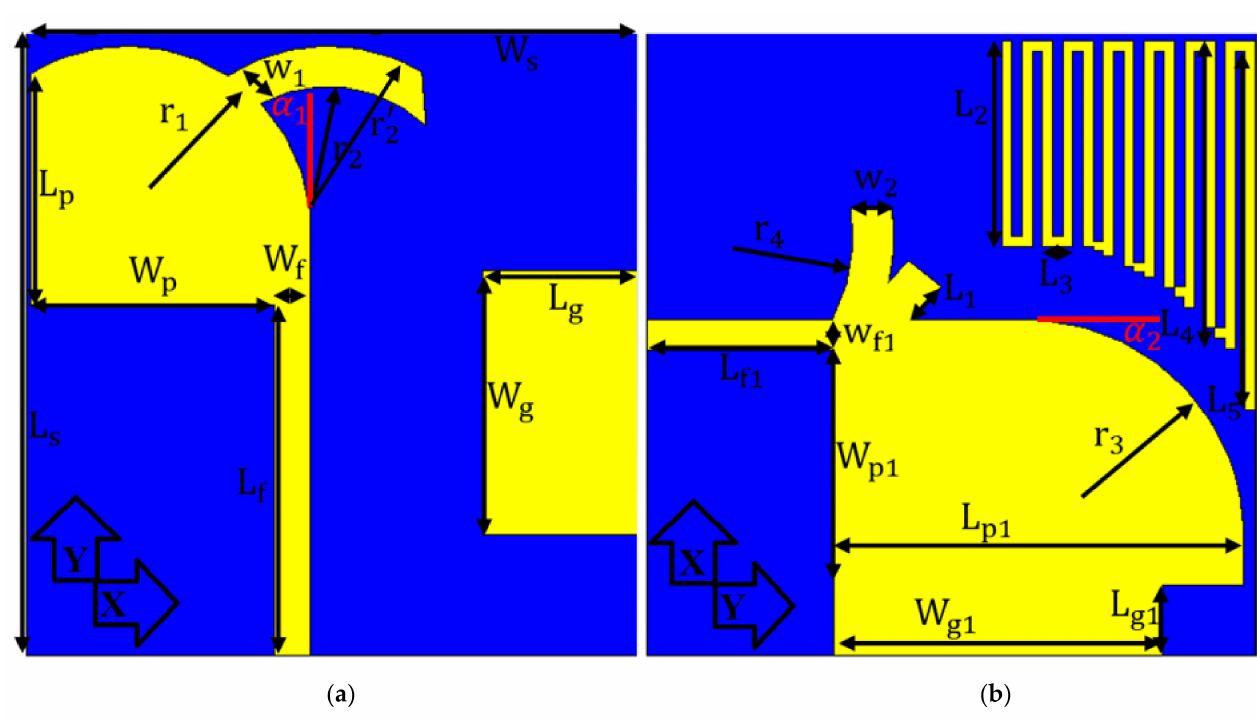
Figure 1. ( a ) front and ( b ) back view of the simulated prototype of the proposed antenna. Table 1. Optimized dimensions of